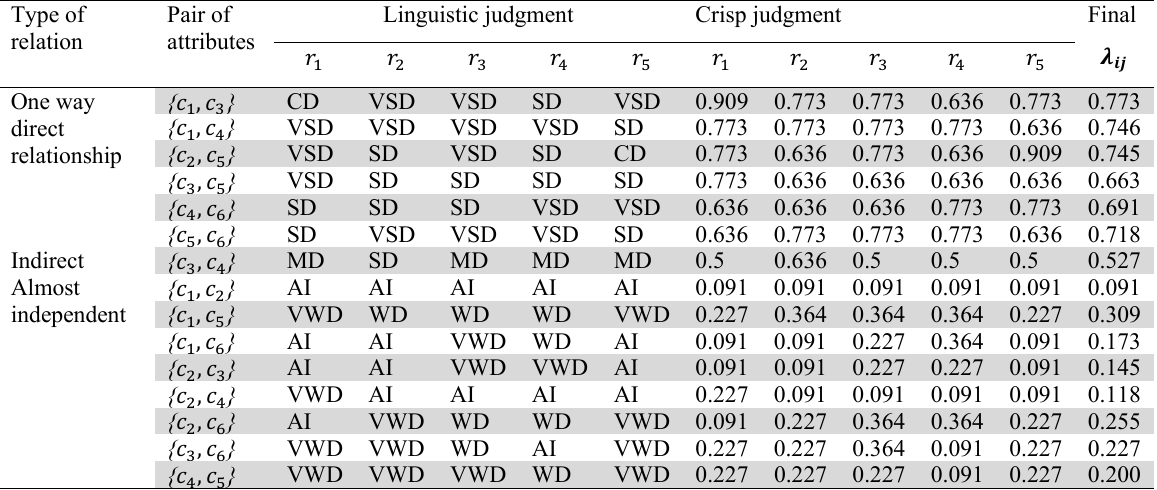
Identification of λ